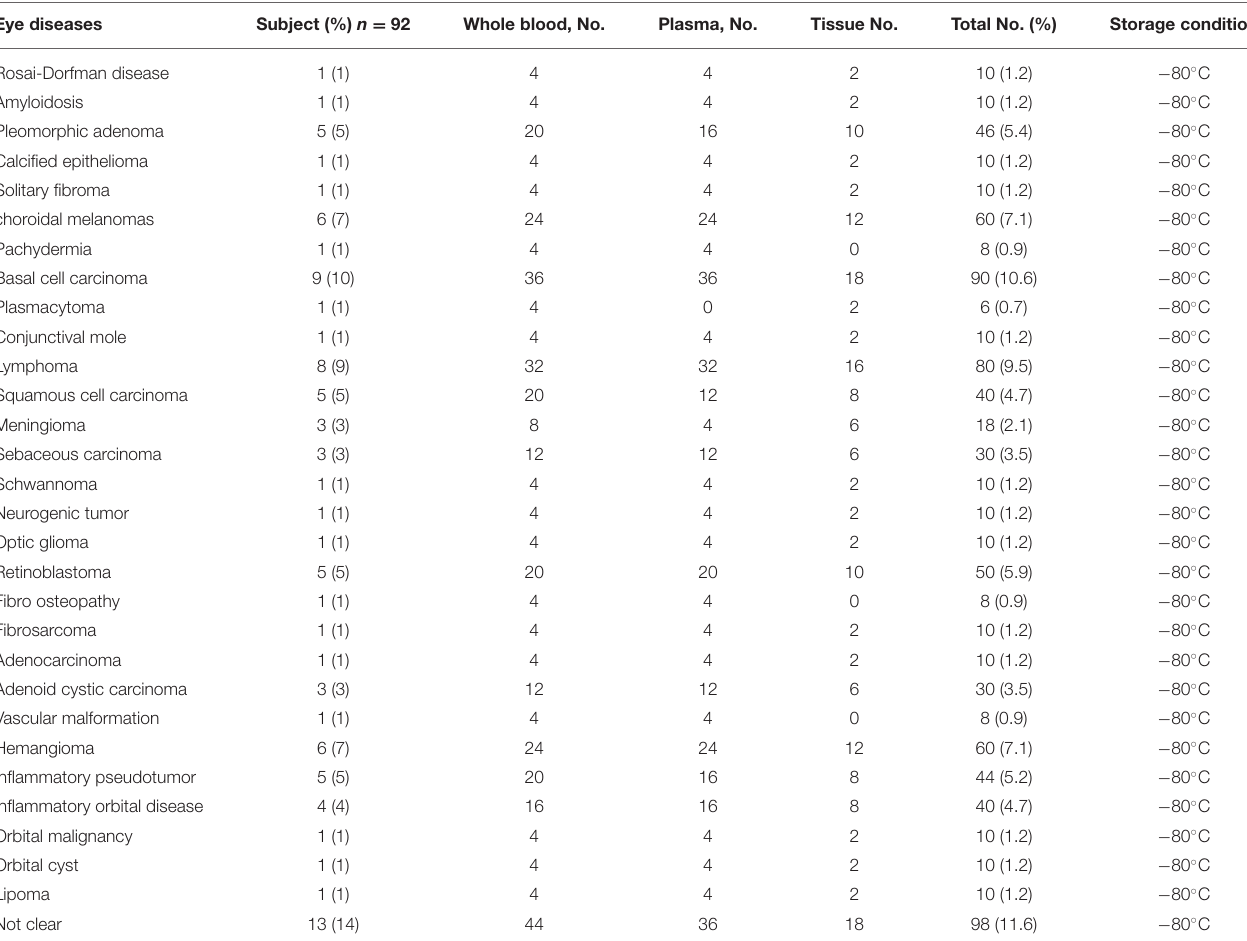
TABLE 1 | Overview of specimen collection of ocular tumor biobank. Eye